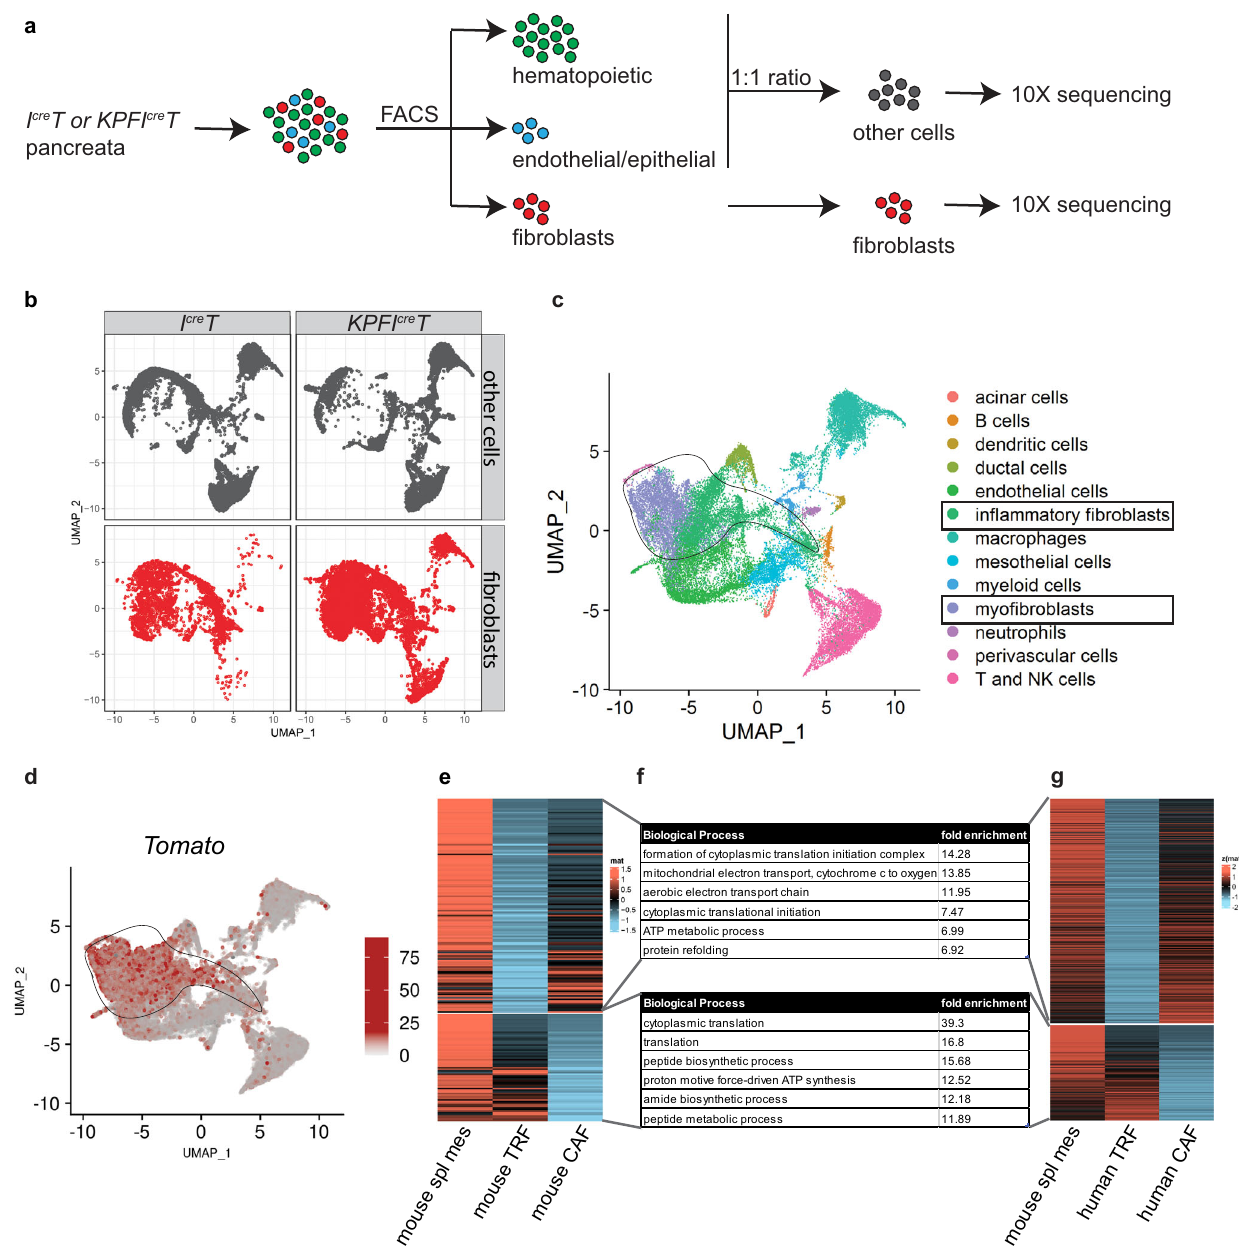
Fig. 5 | Single-cell analysis of the KPFI cre T model suggests a conserved gene signature in the splanchnic lineage. a Schematic of the single-cell RNA sequen- cing experimental design. Pancreata were dissociated into single cells and sorted into hematopoietic cells (CD45+),endothelial(CD31+)/epithelial(EPCAM+) cells or fi broblasts(PDPN+orPDGFR α +,orTomato+).Hematopoieticcellswerecombined with endothelial/epithelial cells with 1:1 ratio. Cells were then processed for 10X RNA sequencing. b The split view of each sample type in a merged UMAP space. c UMAP of cell clusters annotated based on marker gene expression. d Tomato geneexpressionprojectedontothecellclusters. c , d Thecircledlinesdelineatethe fi broblast cluster. e Heatmap of genes highly expressed in both the splanchnic